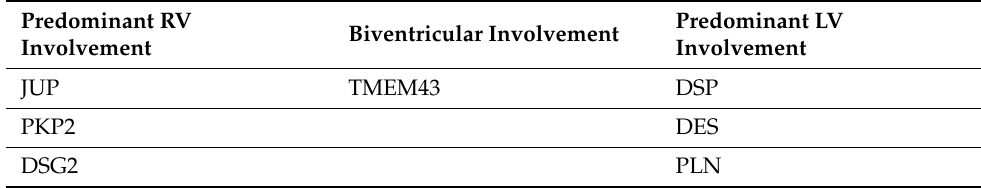
Table 1. Affected gene and corresponding ventricular involvement on ACM.